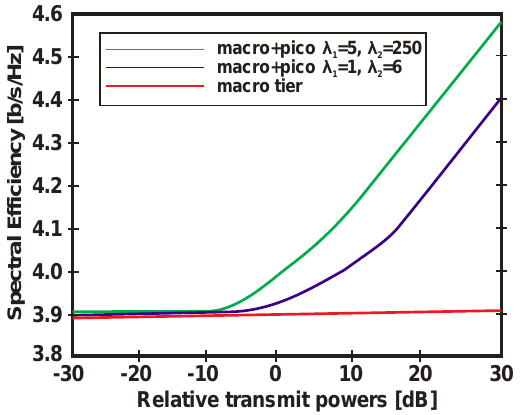
Figure 5. SE vs. transmit powers ratio.